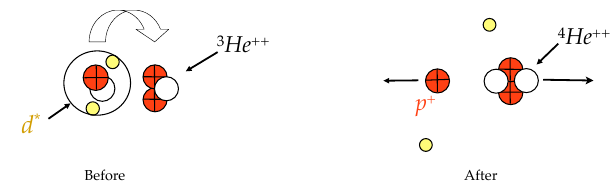
Fig. 4. An illustration of the deuteron tresino d ∗ – 3 He neutron trans- fer reaction. Protons (in red), neutrons (colorless), and electrons (in yellow).